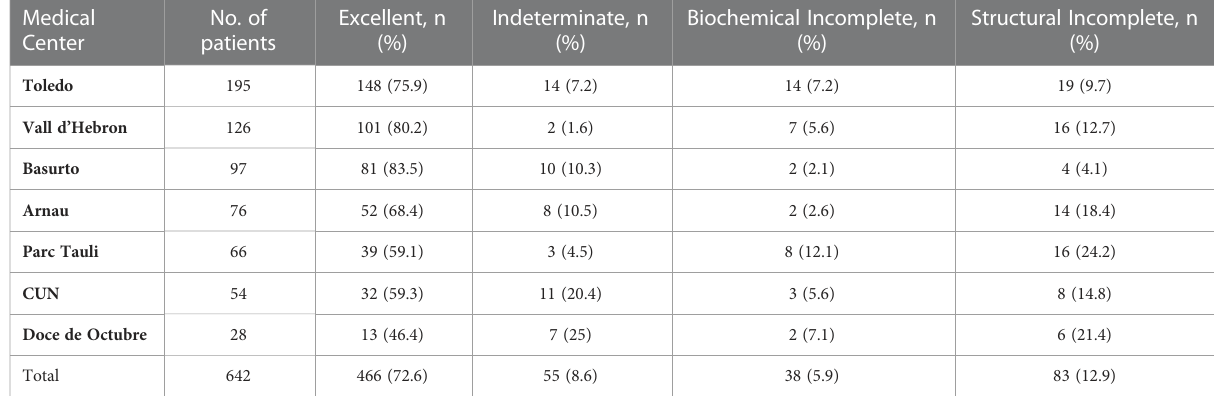
TABLE 2 Response to therapy categories in 642 patients with collected data. Medical Center